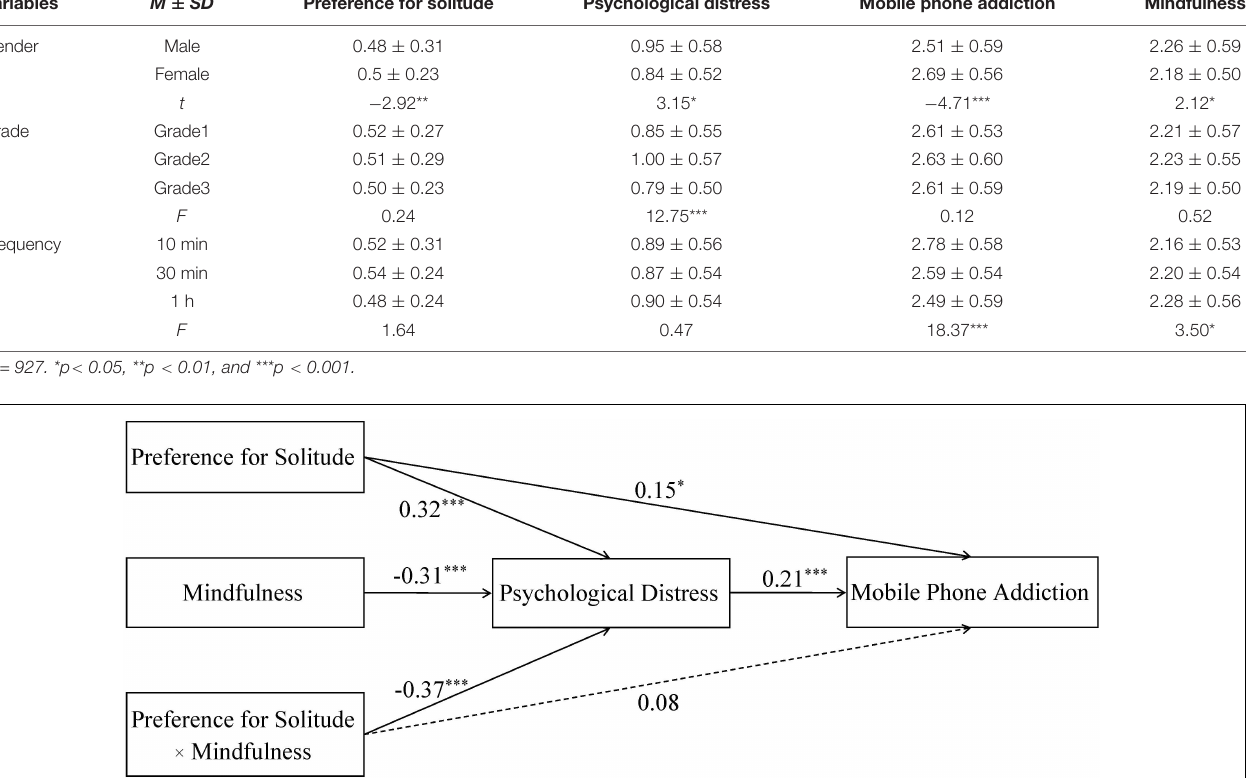
TABLE 2 | The differences of the observed variables in gender, Grade-level and frequency of mobile phones use. Variables M ± SD Preference for solitude Psychological distress Mobile phone addiction Mindfulness